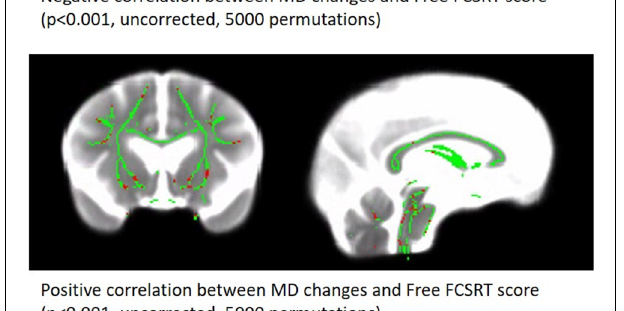
FIGURE 3 | Correlation between MD changes Map and free verbal recall scores. Significant voxels are red ( p < 0.001, uncorrected, 5,000 permutations). The results are presented on the skeleton of the cohort (green) display on a subject MD